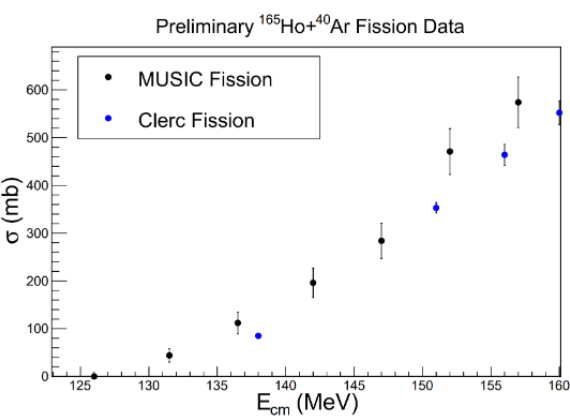
Figure 2. Preliminary experimental cross section of fusion-induced fission events measured in MUSIC for the 165 Ho + 40 Ar → 205 At system compared with data from Ref.